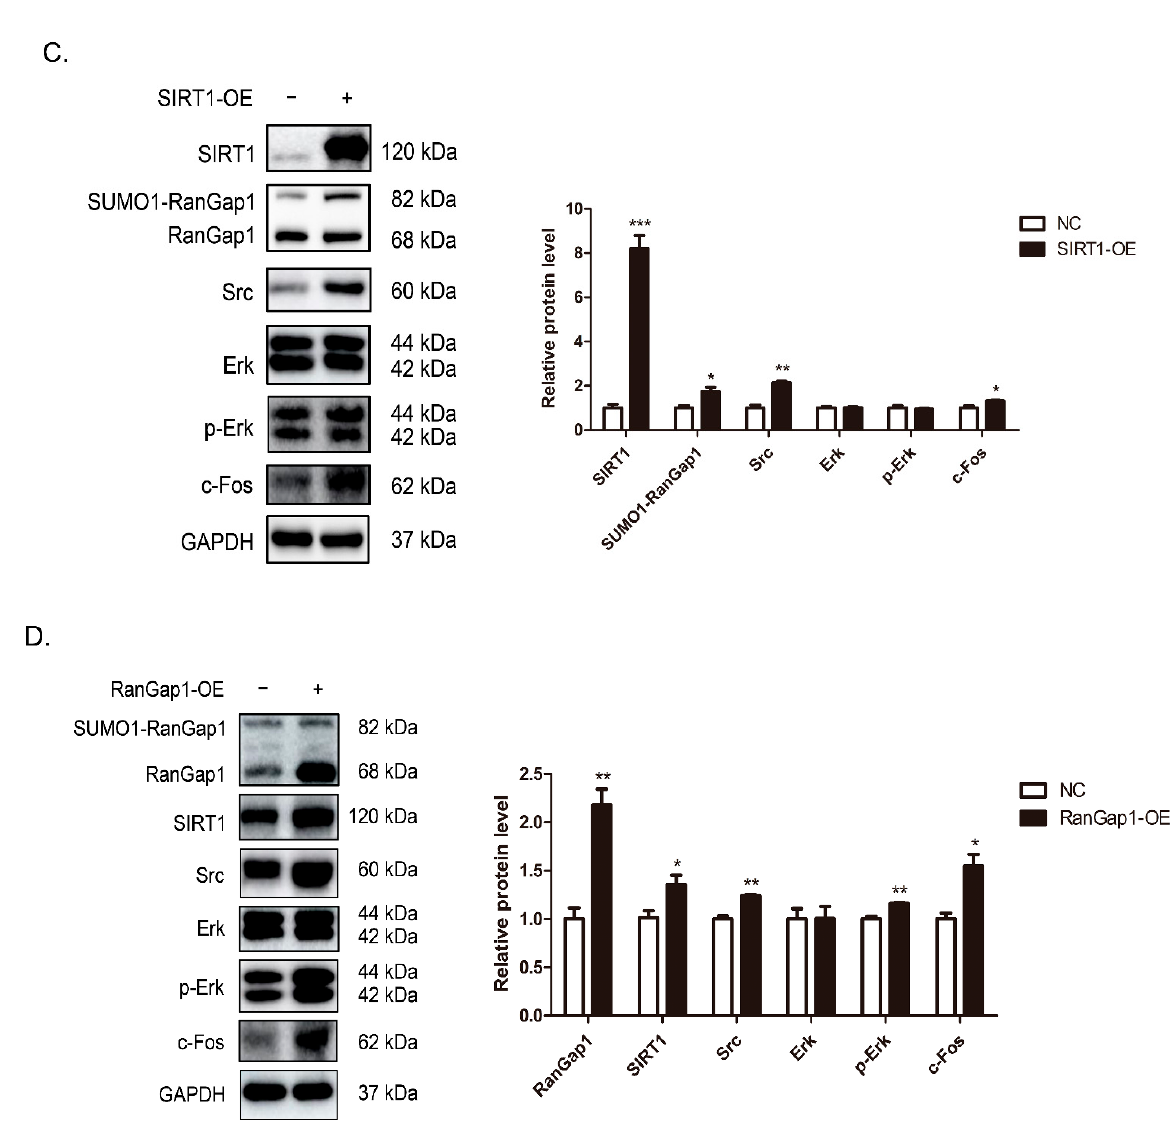
Figure 6. SIRT1 and RanGap1 have effects on Src/Erk/c-Fos pathway. Overexpression and knock- down of SIRT1 and RanGap1 were established in MCF-7 cells, and the protein levels were detected by Western blot. ( A ) RanGap1, Src and c-Fos were decreased in SIRT1-KD cells. ( B ) SIRT1, Src, p-Erk and c-Fos were decreased in RanGap1-KD cells. ( C ) SUMO1-RanGap1, Src and c-Fos were increased in SIRT1-OE cells. ( D ) SIRT1, Src, p-Erk and c-Fos were increased in RanGap1-OE cells. The GAPDH was used as a loading control. The pooled data were shown here as the mean ± SEM, and the significant differences from control cells were shown in p < 0.05 (*), p < 0.01 (**), and p < 0.001 (***). The independent experiments were repeated at least three